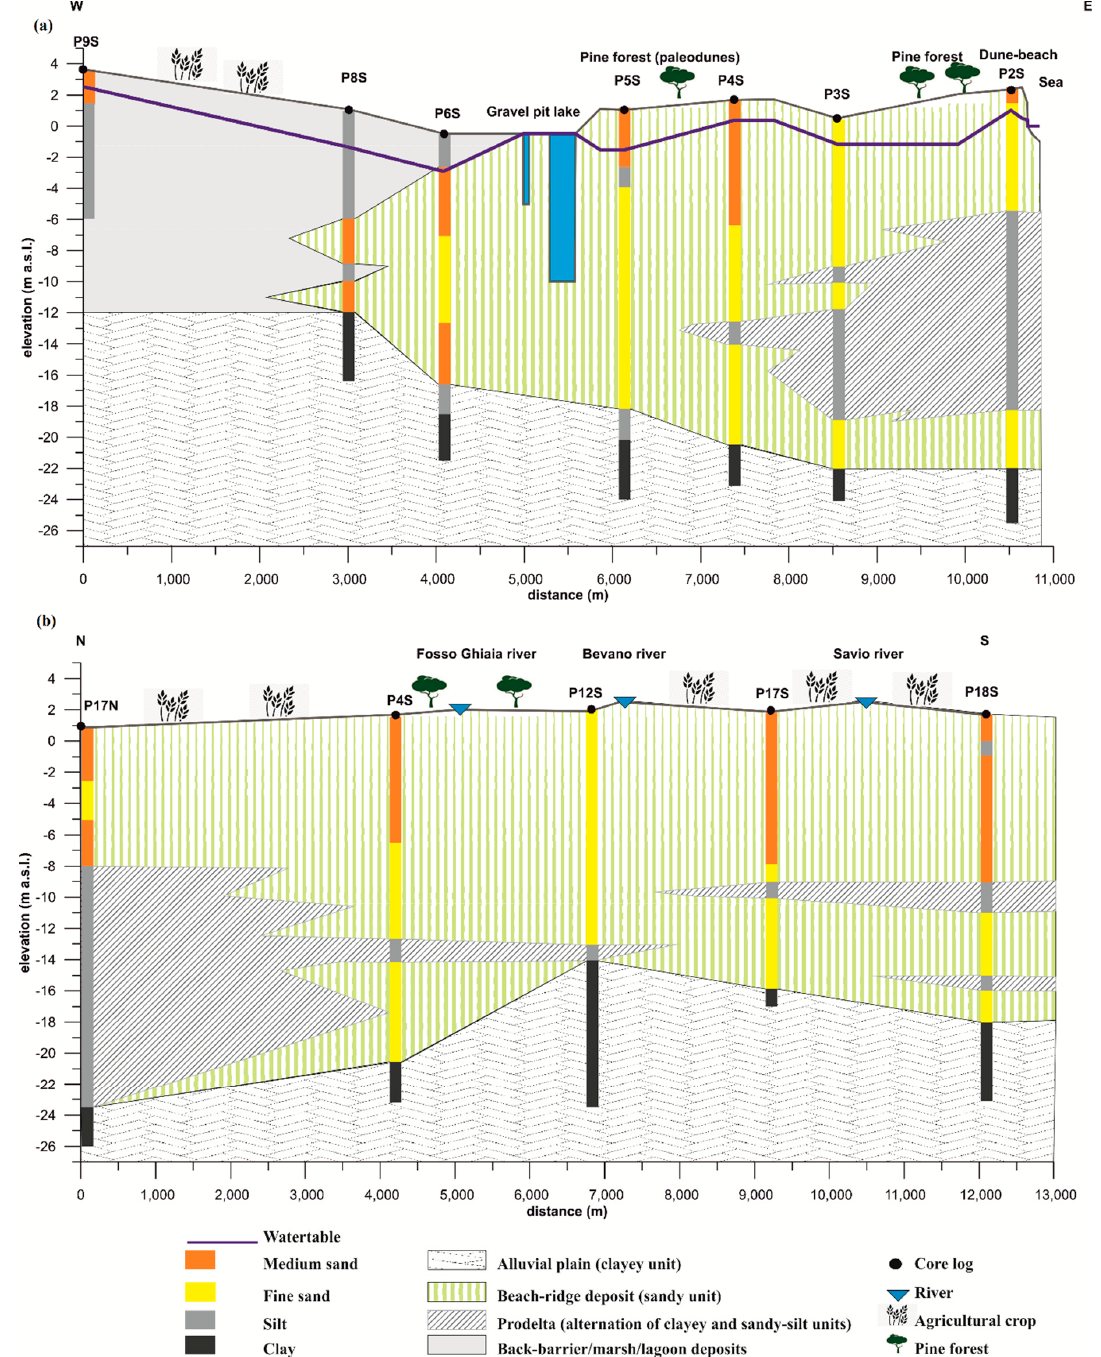
Figure 3. West-East ( a ) and North-South ( b ) cross-sections across the study area and lithostratigraphic reconstruction of the coastal aquifer. Refer to Figure 2 for the profile locations. Water table depth is based on average of several monitoring campaigns [19,25,28–31,43] carried out in the same area during previous